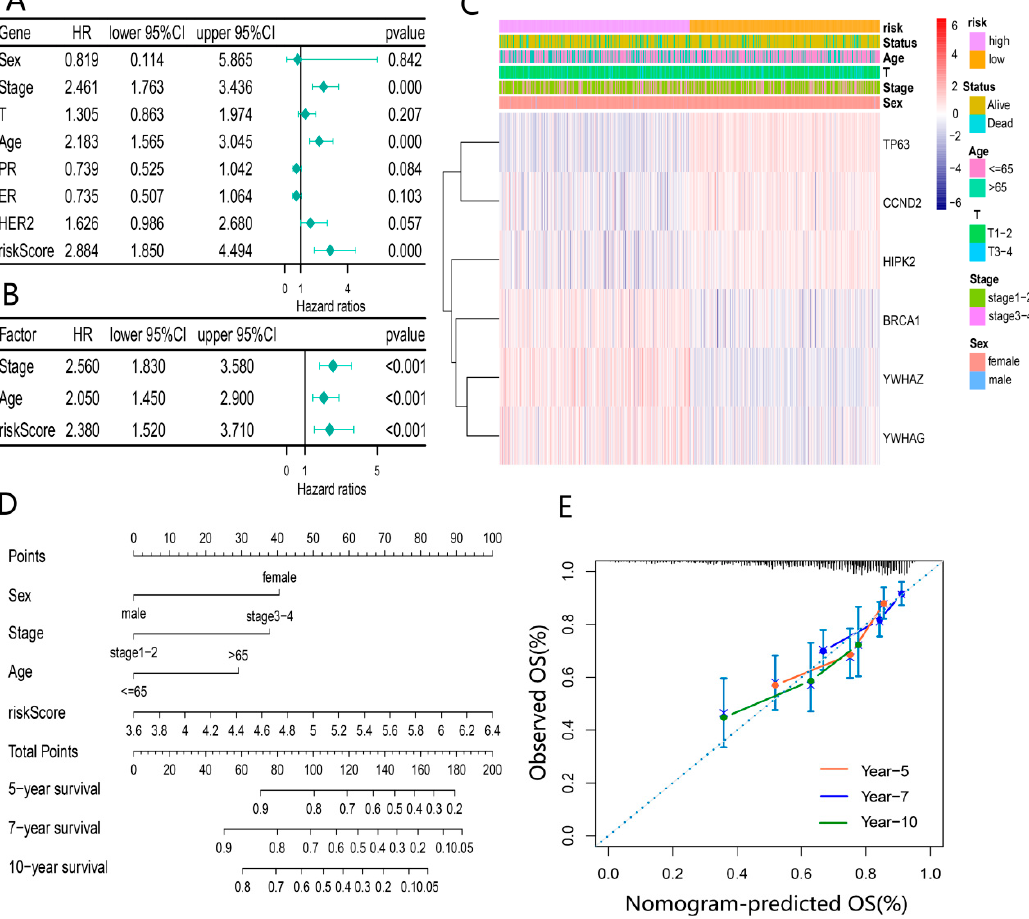
Figure 6. Evaluation of independent prognostic value of the risk model: ( A ) univariate COX regres- sion analysis based on the risk score and clinical characteristics; ( B ) multivariate COX regression analysis for independent prognostic factors; ( C ) heatmap of 6-DEDGs based on different risk groups with pathological characteristics; ( D ) prognostic column line graph for predicting 5-year, 7-year and 10-year overall survival in BRCA patients; ( E ) the calibration curves of the nomogram for 5-year, 7-year and 10-year survival for BRCA